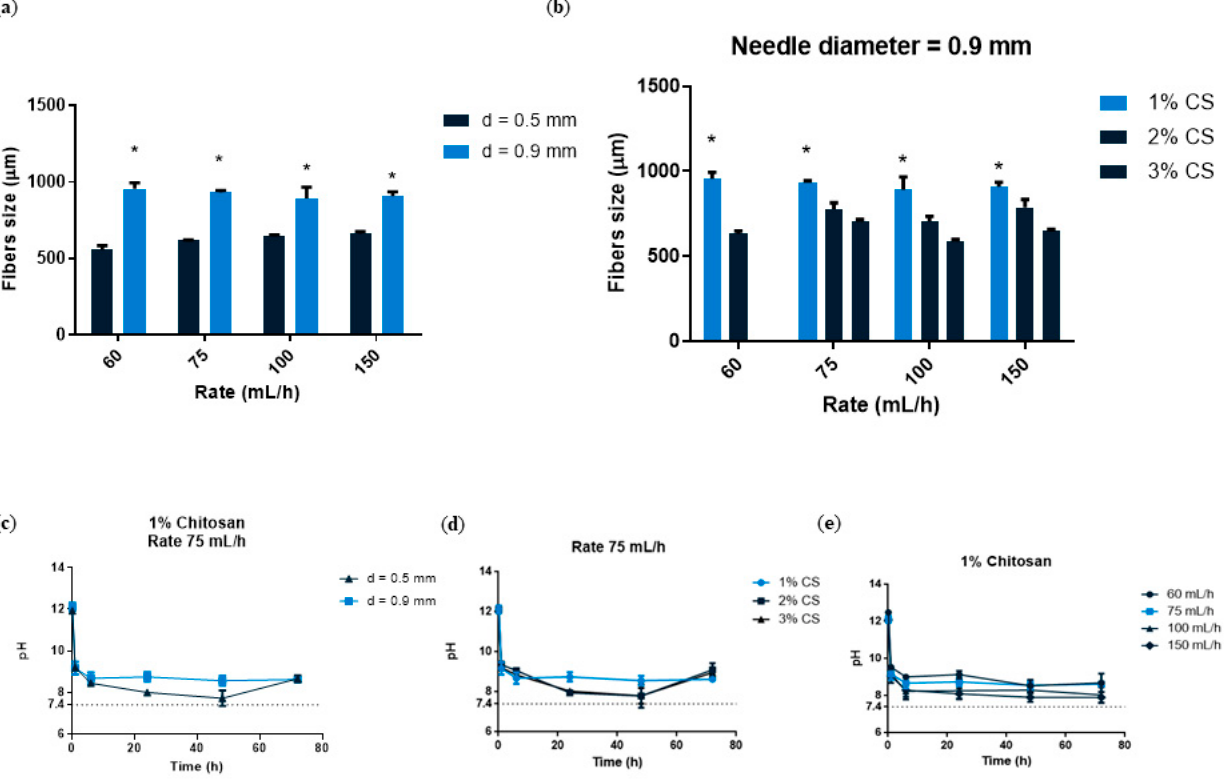
Figure 2. ( a ) CS fibers size at 1, 2 and 3% concentration fabricated with a needle diameter 0.9